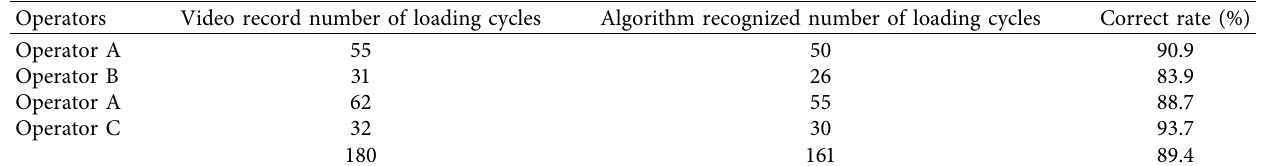
Table 4: Algorithm recognition and classification loading cycle verification